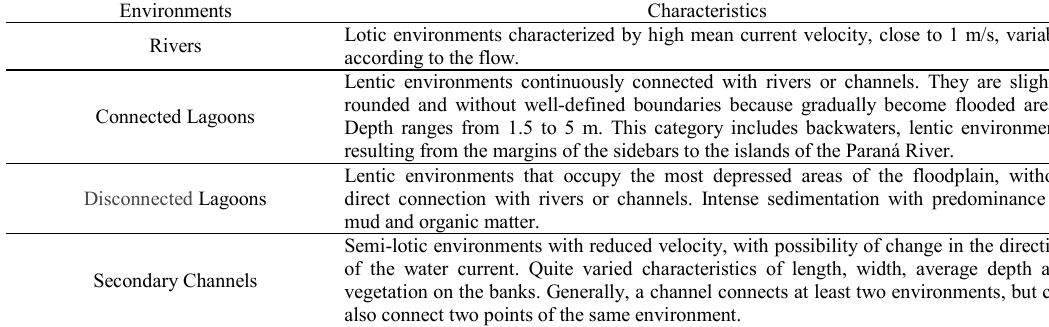
Table 1 . Description of the sampled environments. Environments Characteristics